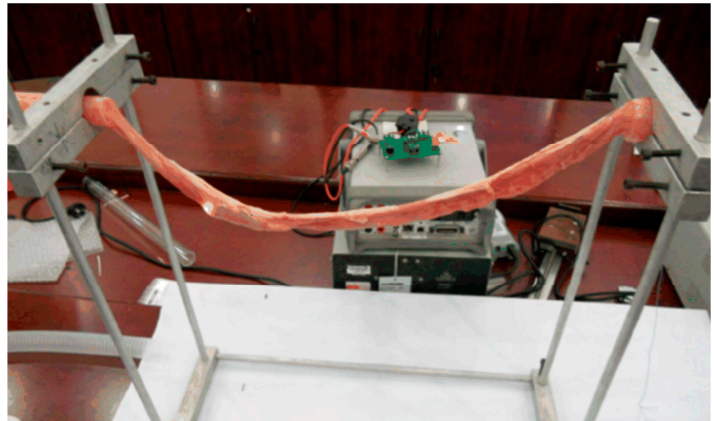
Figure 14. Performance test of the prototype in an intestinal canal.